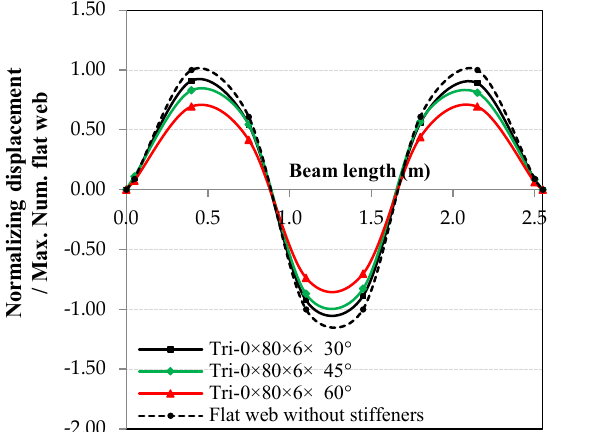
length for the 2nd mode shape: ( a ) triangular web and ( b ) angle effect at the 2nd mode shape.